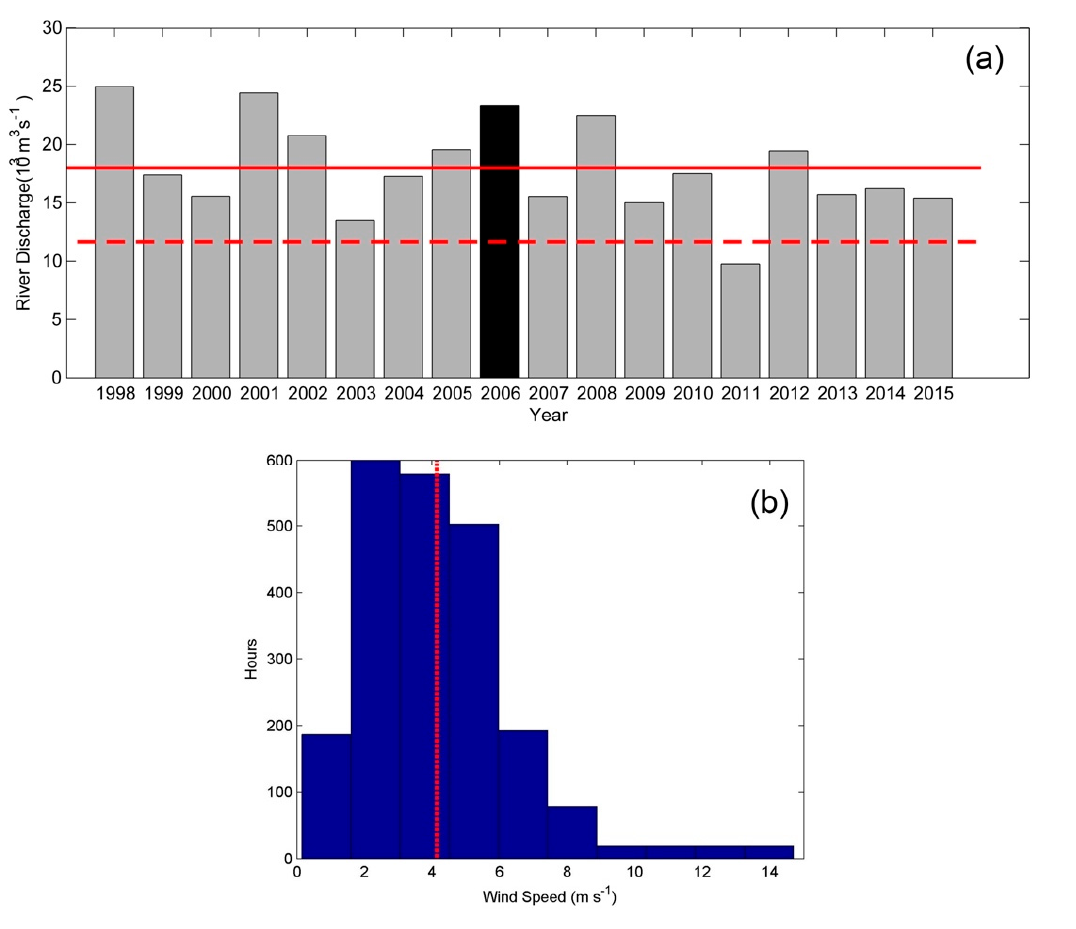
Figure 3. ( a ) Annual river discharge in summer (June–August) from 1998–2015; the red solid line indicates the averaged summertime river discharge; and the red dashed line indicates the 5% percentile of the summertime river discharge. ( b ) Histogram of wind speed distribution in summer 2006. The red line represents the average wind speed (~4.05 m s − 1 ).